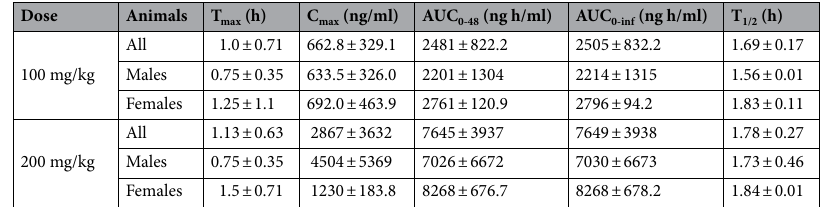
Table 1. Summary of BIO 300 Oral Powder single dose PK parameters in NHPs. Results mean ± SD.